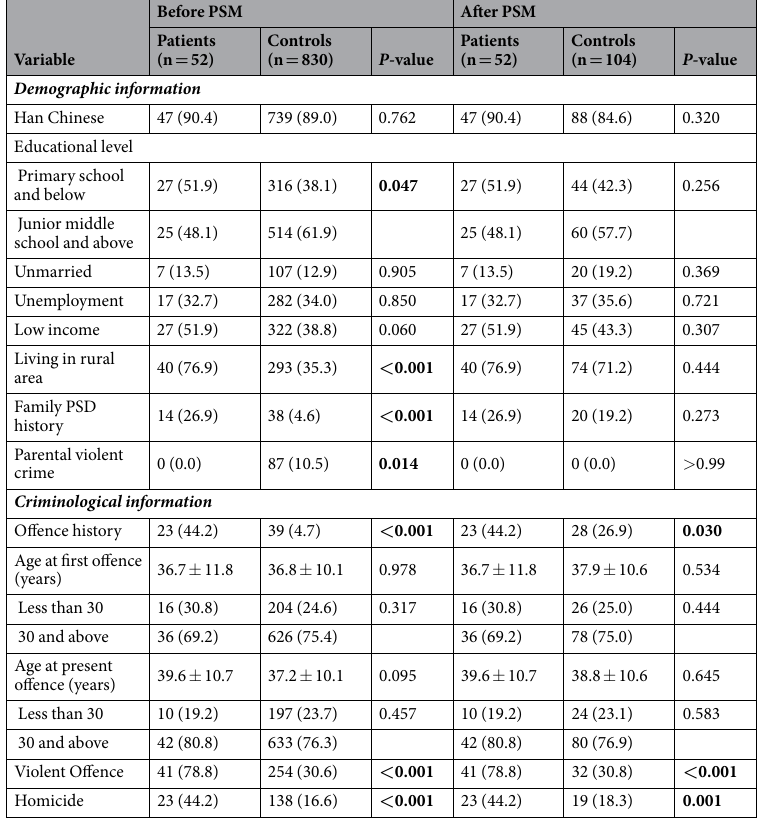
Table 1. Comparisons between patients and controls before and after propensity scores matching (n, %). PSD: psychiatric disorder; PSM: propensity score matching; # Status before arrest; $ The age at present offence was used for persons without an offence